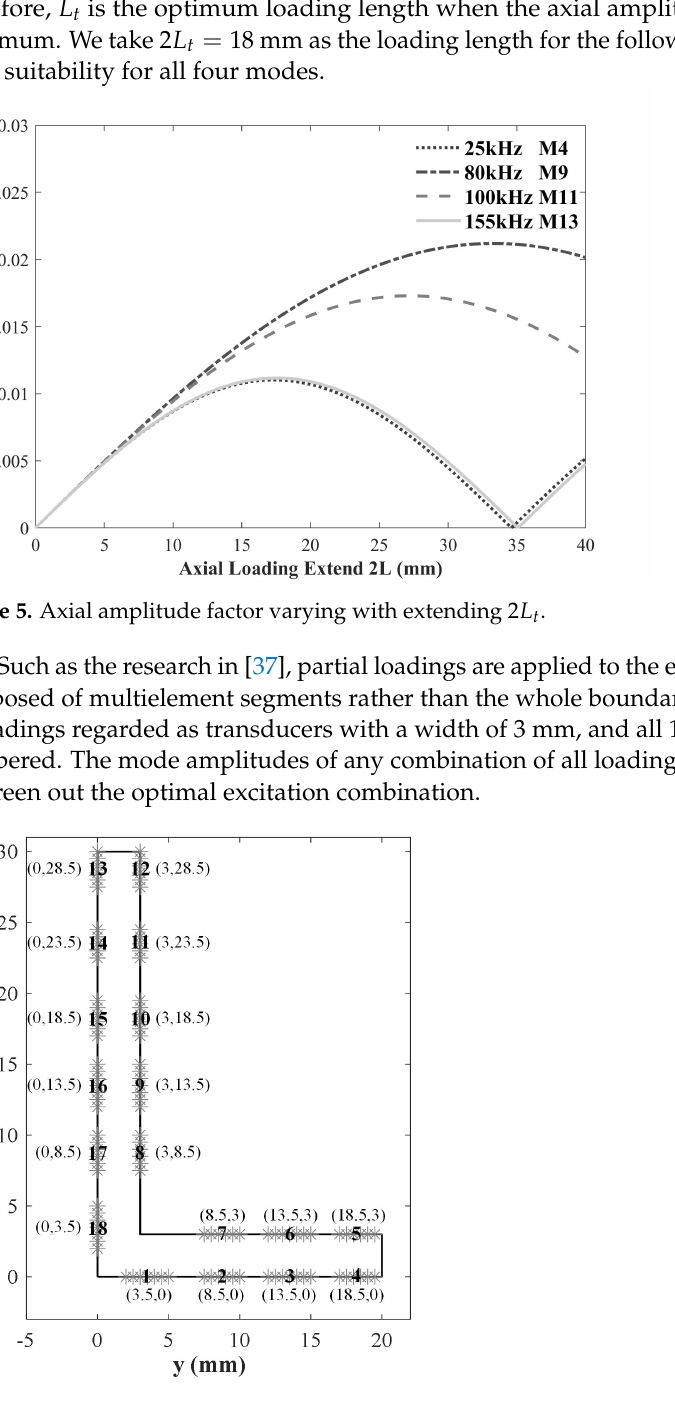
Figure 6. Multielement loading layout for the L-bar, and all loading regions are